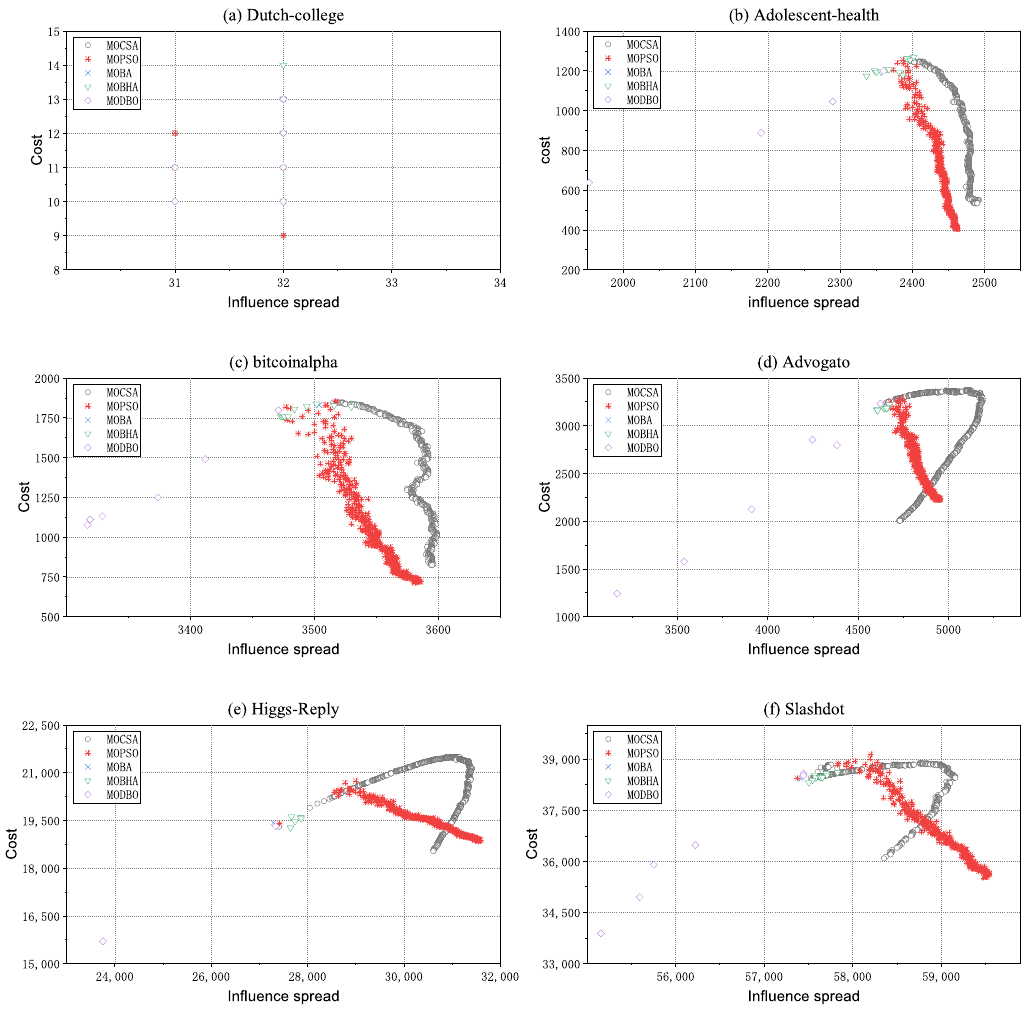
Figure 7. Comparison on Pareto Frontiers of different algorithms on six real social